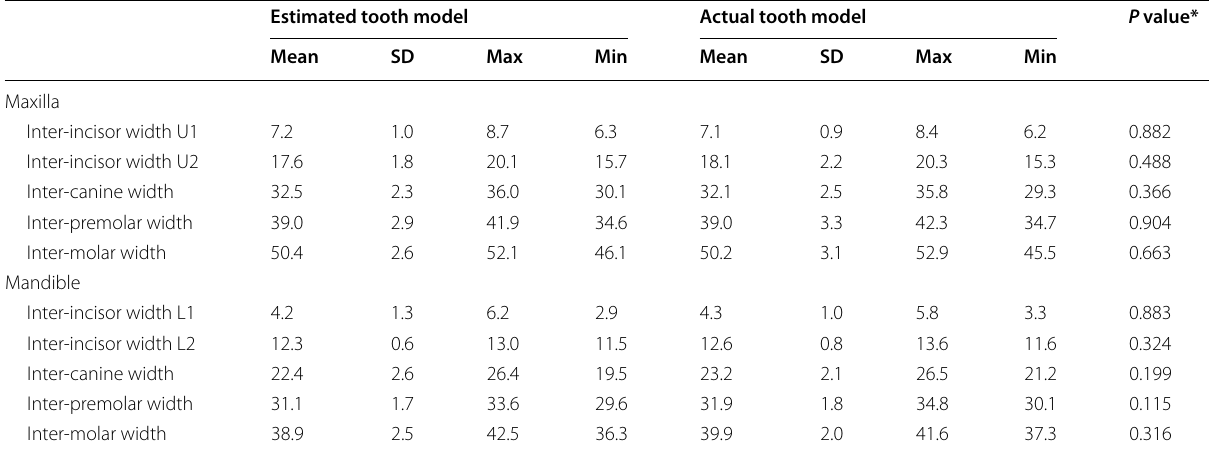
SD, Standarddeviation *The results of paired t test. U1, maxillary central incisors; U2, maxillary lateral incisors; L1, mandibular central incisors; L2, mandibular lateral incisors Table 4 Comparison of inter‑root distance between estimated and actual tooth models in manual method (unit: mm)